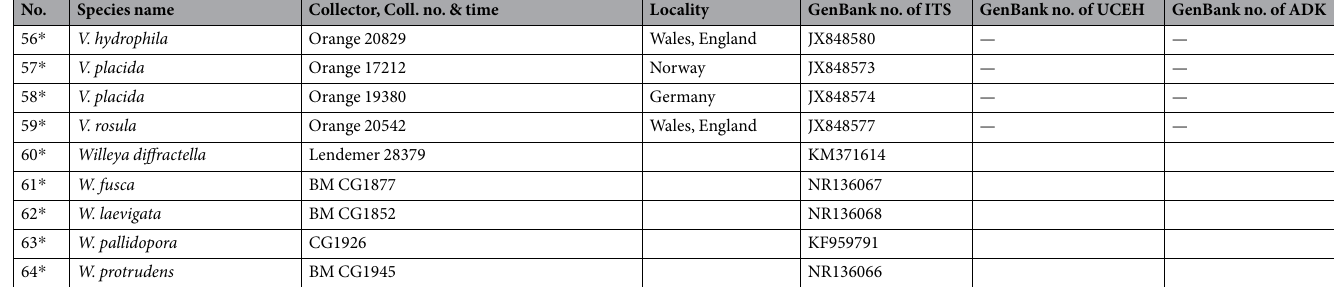
Table 1. Specimen information and GenBank accession numbers for the taxa used in this study. * DNA sequences were downloaded from GenBank. Othe specimens were sequenced by the authors; all sequences were deposited in HMAS-L; missing sequences are indicated by